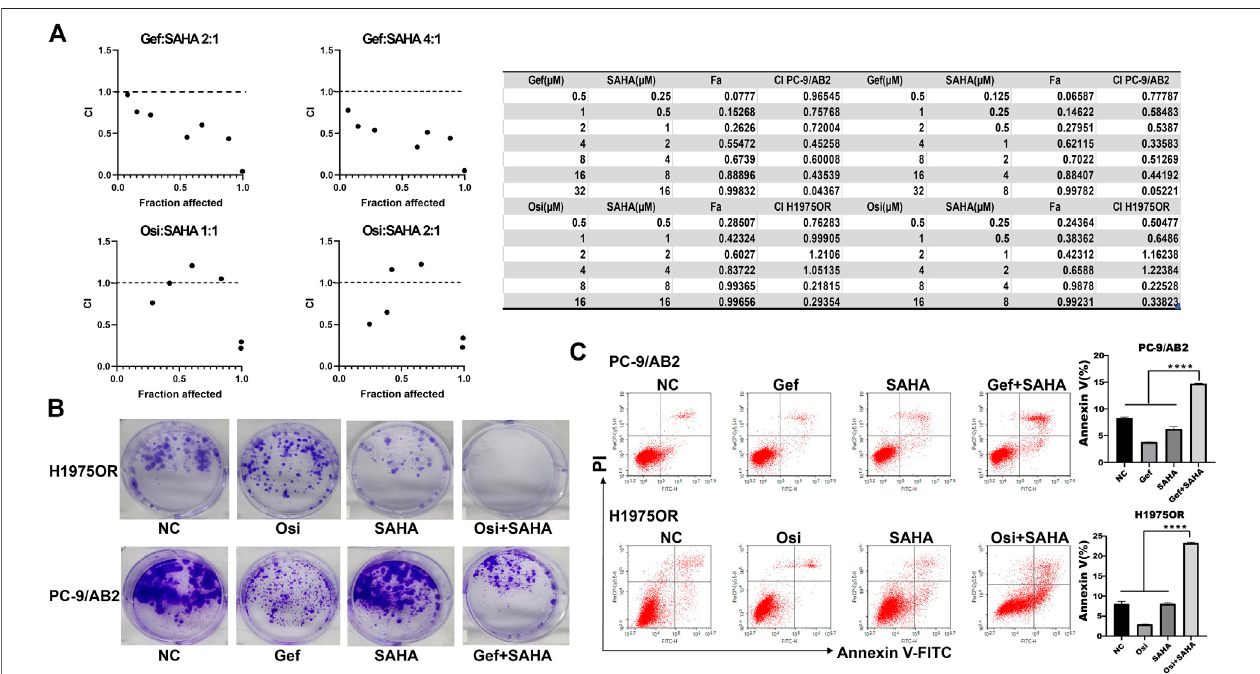
FIGURE4| SAHA enhanced the antitumor effect ofEGFR-TKIs in vitro . (A) PC-9/AB2 and H1975OR cells wereincubated withdifferent concentrationsofge fi tinib or osimertinib combined with SAHA for 48 h. Cell viability was determined using the CCK-8 method. The combination effect of the two drugs was then evaluated accordingtothecombinationindex(CI). (B – C) NC:DMSO,Gef:1 μ Mge fi tinib,Osi:1 μ Mosimertinib,SAHA:1 μ MSAHA,Gef+SAHA:1 μ Mge fi tinib+1 μ MSAHA,Osi + SAHA: 1 μ M osimertinib + 1 μ M SAHA. The colony formation assay suggested that the number of colonies in the two-drug combination group was signi fi cantly lowerthan thatinthesingle-drug group. Detectionofapoptosis by fl owcytometryrevealedthattheproportion ofapoptotic cellsinthetwo-drug combinationgroupwas much higher than that in the single-drug and NC groups. The bar graph shows the percentage of apoptotic cells in different groups ( n = 3, **** p < 0.0001).